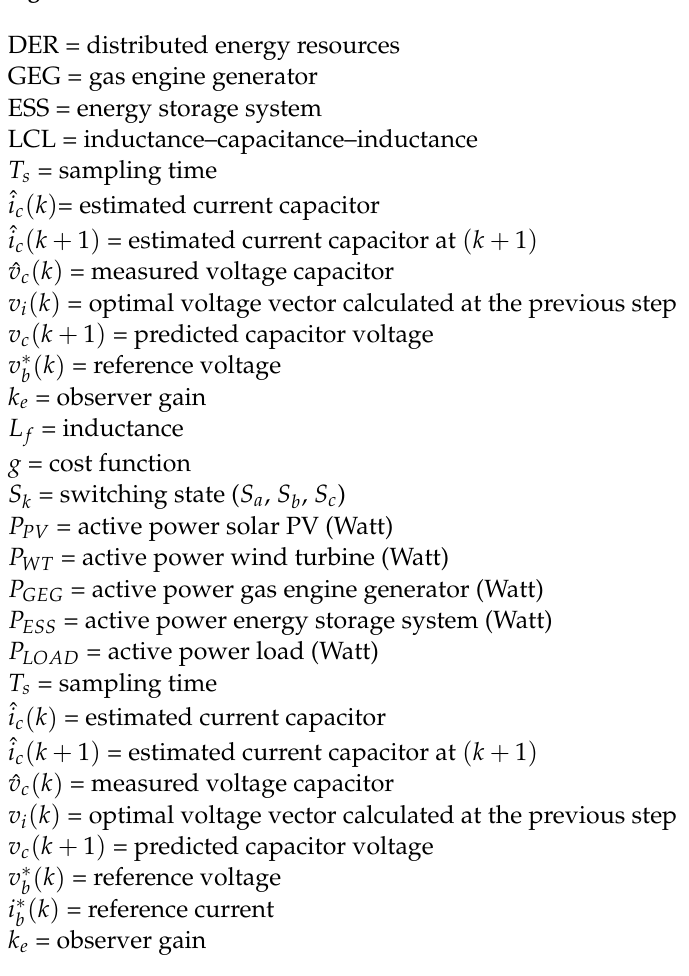
Figure 16. MPC-based EMS with the current observer.